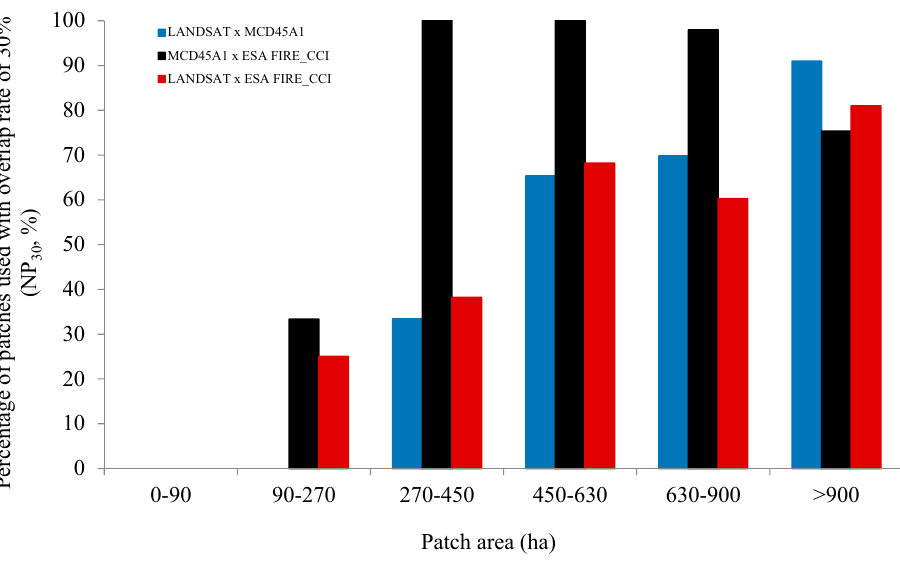
Figure 5. Percentage of patches actually analyzed (Y axis) with an overlapping rate threshold of 30% (NP 30 ) by patch size classes (X axis), for comparisons of LANDSAT × MCD45A1 (blue), MCD45A1 × ESA FIRE_CCI (black) and LANDSAT × ESA FIRE_CCI (red).